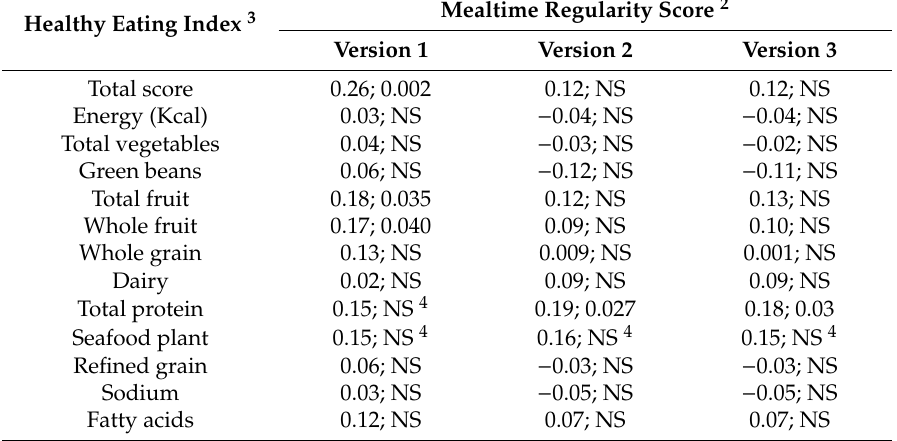
Table 4. Correlation between mealtime regularity scores and healthy eating index scores controlled for pattern of recall days among 142 parents of 4th grade children participating in a culinary and physical activity program 1